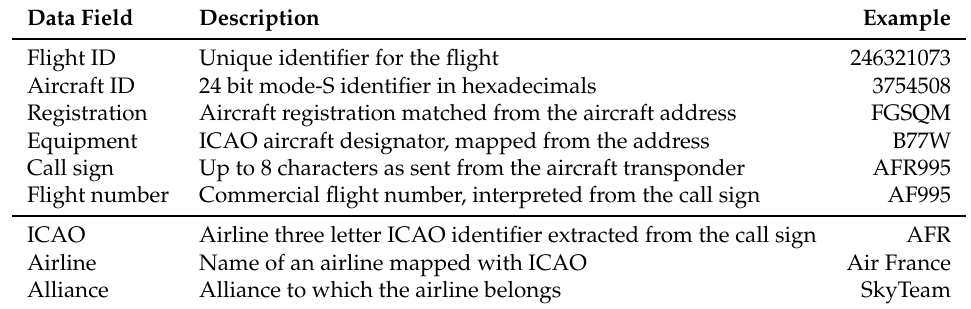
Table 1. Metadata of the dataset segment containing the flight data. ICAO, International Civil Aviation Organization.